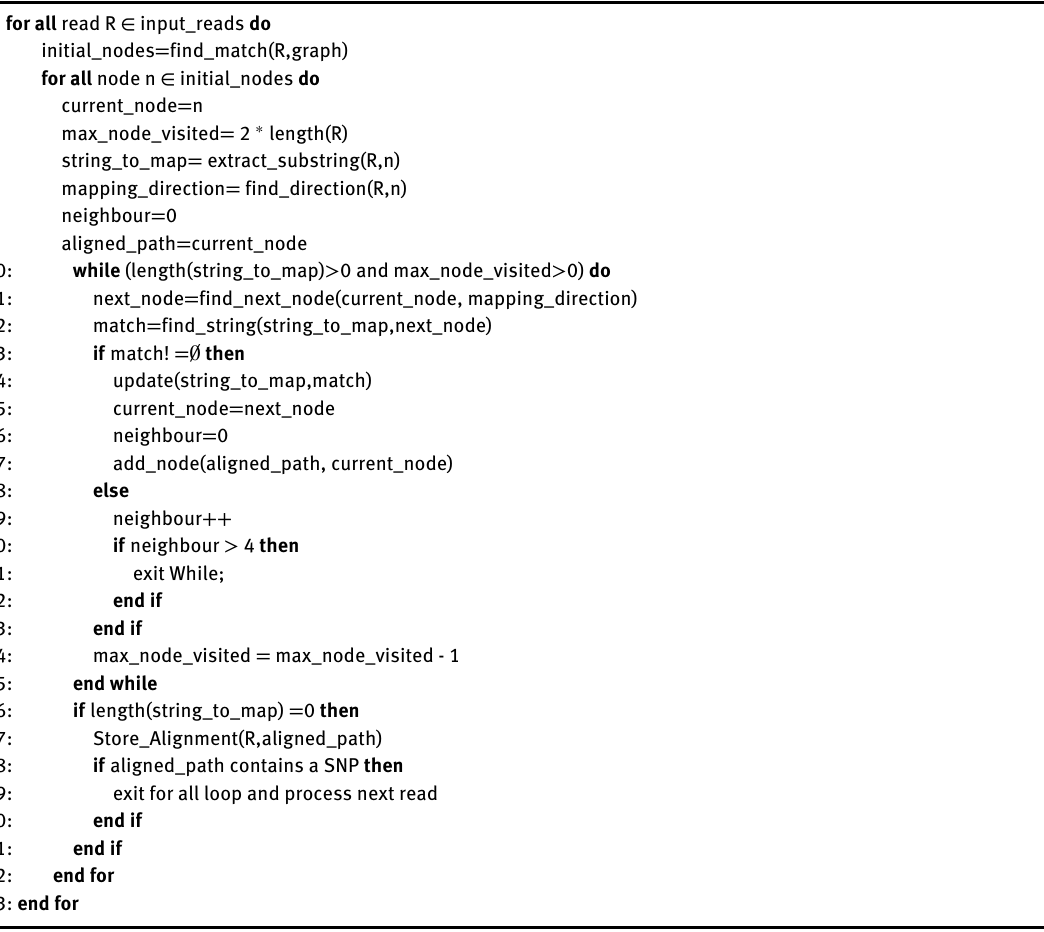
Algorithm 1. VG SNP-Aware mapping (input_reads,